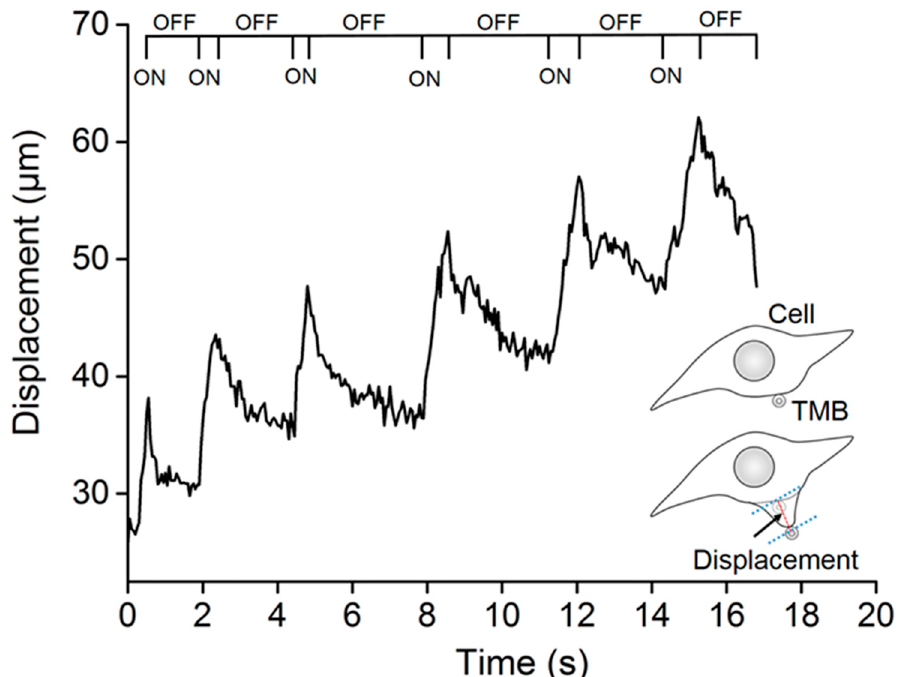
Figure 5. Effect of TSAW stimulation on TMB translation. After ultrasound excitation, the TMBs moved in the direction of TSAW propagation. Once the ultrasound stopped stimulating, the TMBs partially moved back to the original position.